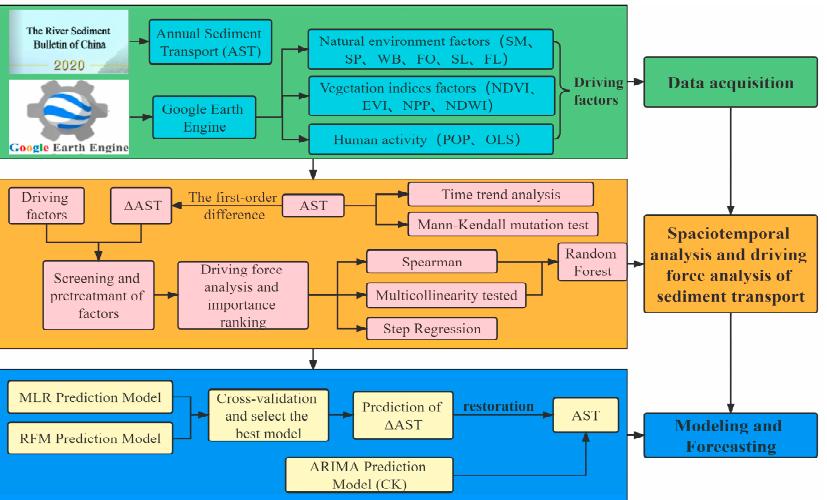
Figure 2. Flowchart showing the analysis of the factors driving ∆ AST in the UMRYR and the trend prediction of AST. The abbreviations, AST and ∆ AST, denote the annual sediment transport and amount of the interannual variation in the annual sediment transport, respectively. Table 1 shows the short meanings of the variables. The abbreviations, MLR and RFM, denote the multiple linear regression and random forest model, respectively.